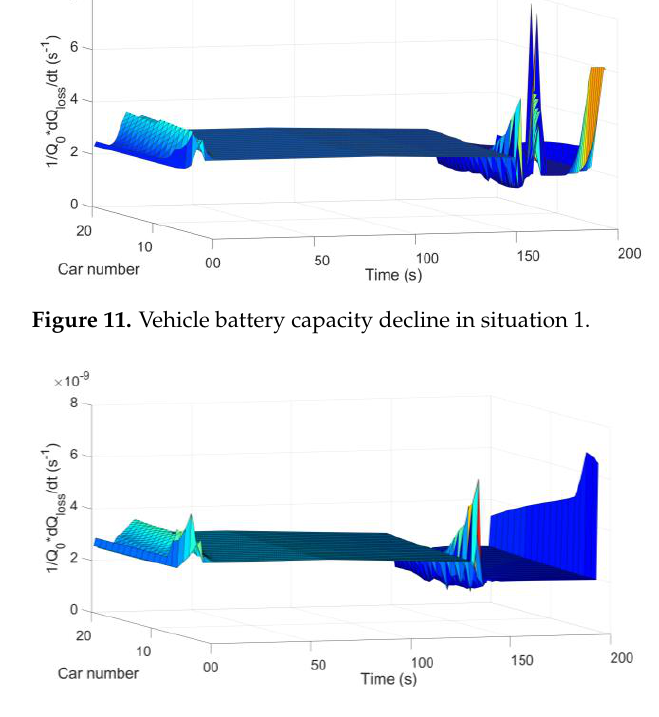
Figure 13. Vehicle battery capacity decline in situation 3.